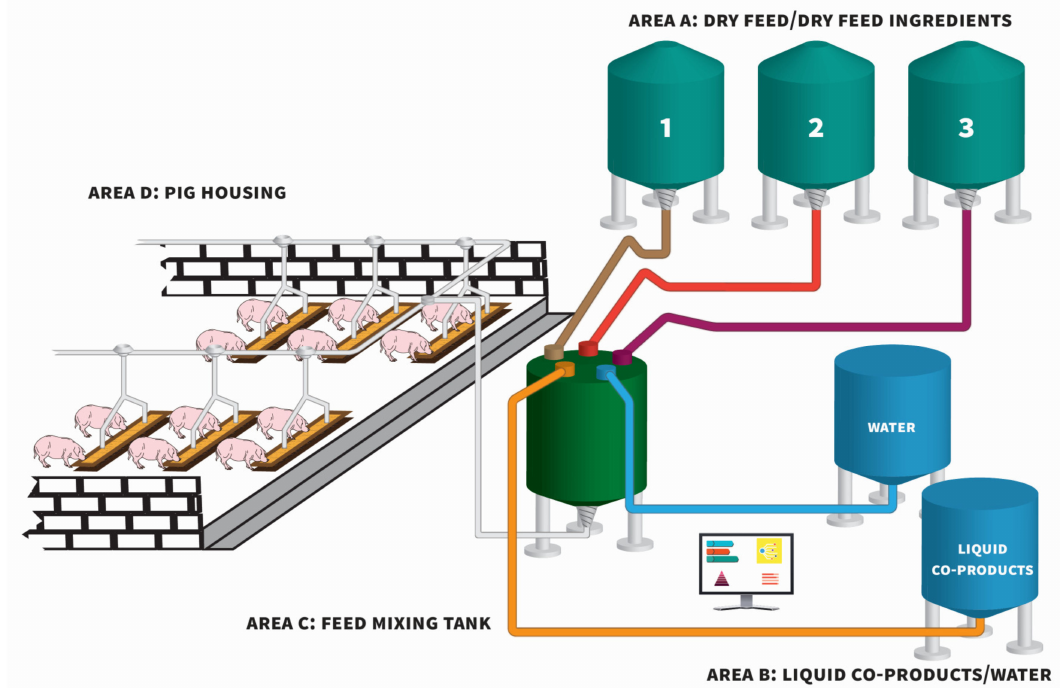
Figure 1. Diagram of an automated liquid feeding system demonstrating how dry feed/dry feed ingredients from feed bins (Area A) and water and/or liquid co-products (Area B) are delivered to a central mixing tank (Area C) and agitated, followed by the delivery of liquid feed to pens via a series of pipes for consumption by pigs (Area D). On farms where fermentation is practiced, an additional fermentation tank may be included before the mixing tank, where the whole diet or the cereal fraction of the diet are fermented for a period of time prior to pumping to the mixing tank for delivery to the